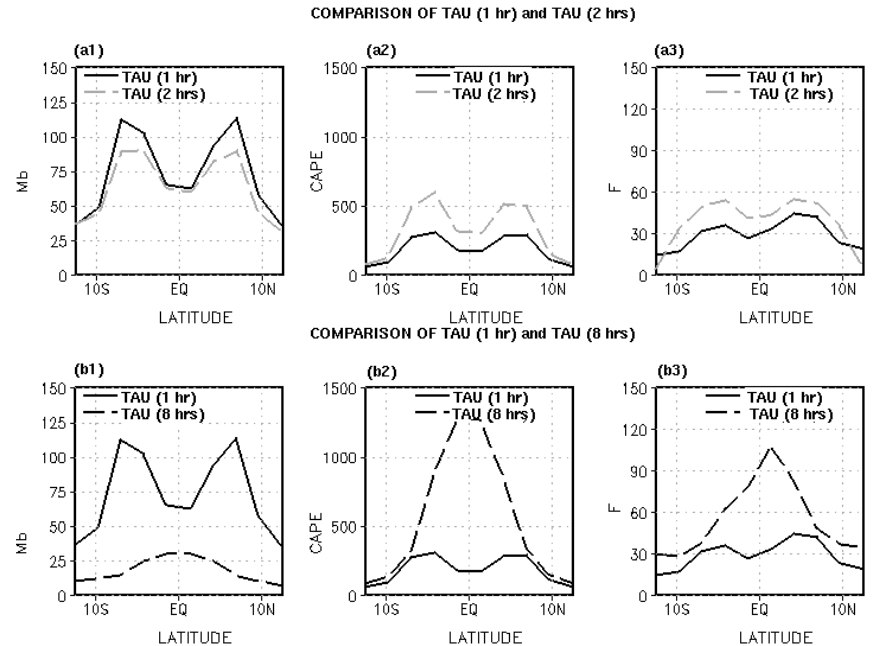
Fig. 5. Zonal averaged time mean quantities. Top panel shows the comparison of TAU (1h) and TAU (2h), and bottom panel shows the comparison of TAU (1h) and TAU (8h). (a1) and (b1) show the cloud base mass flux (mb/day), (a2) and (b2) show CAPE (J/Kg), (a3) and (b3) show F , which is the CAPE consumption rate per unit cloud base mass flux (J/Kg/Mb).